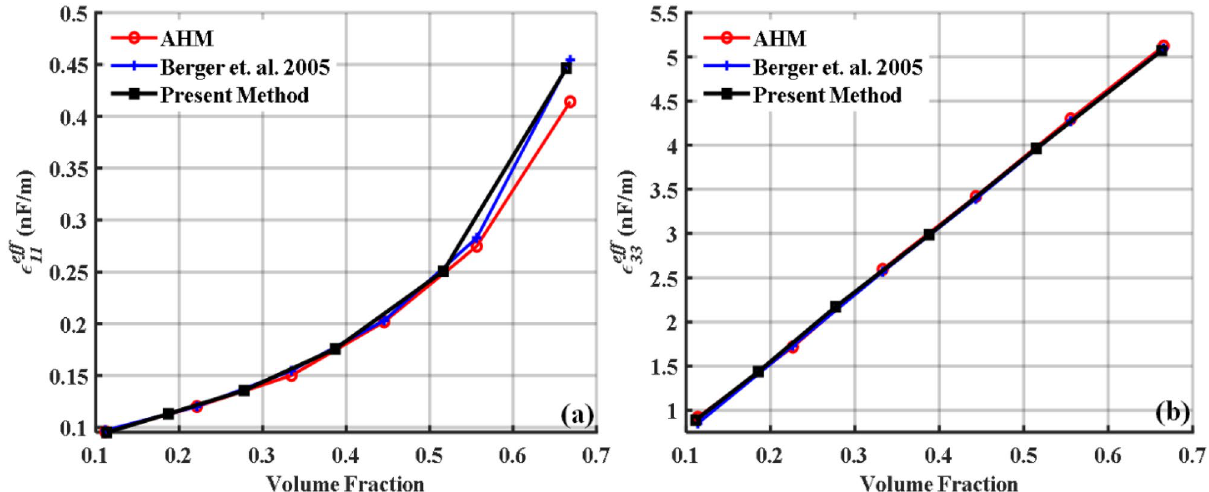
Figure 20. Validation of present model by comparing effective relative permittivity.